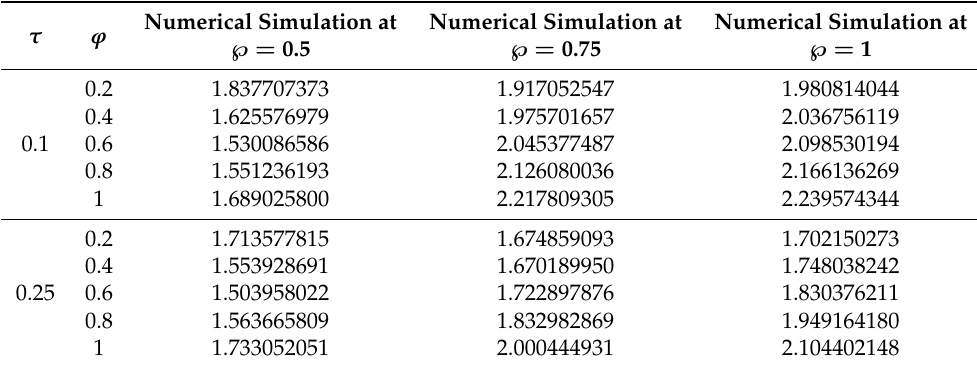
Table 3. Numerical analysis of u ( ϕ , τ ) of the example given in 2 with different values of ϕ , τ , and p = 2 . 3